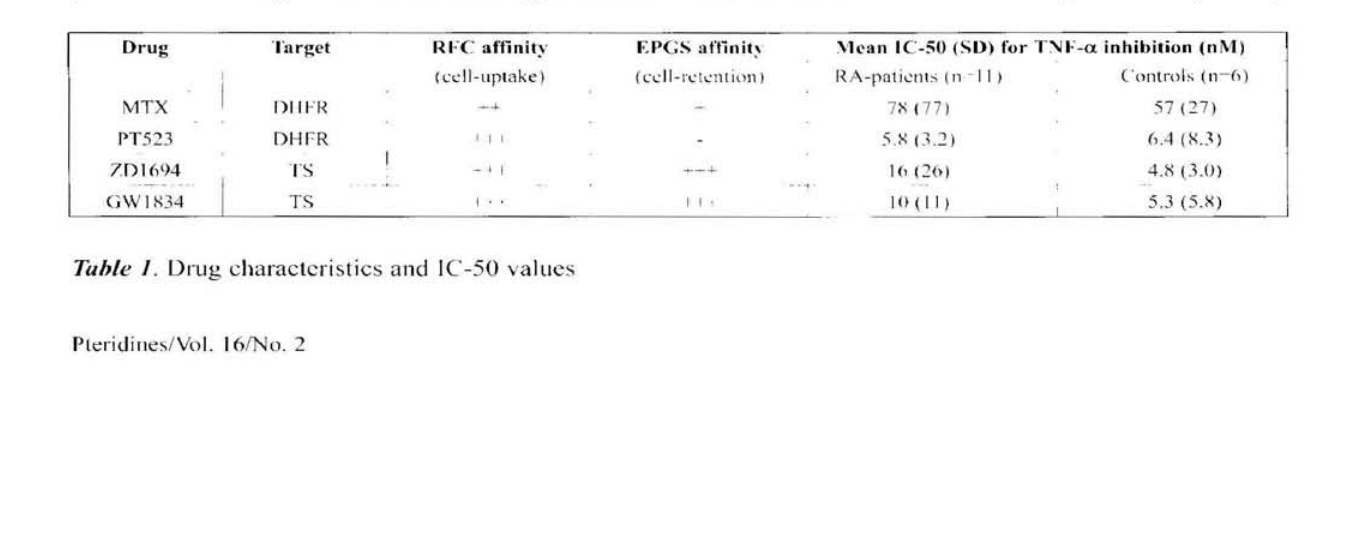
Pteridines/Vol. 16/No.